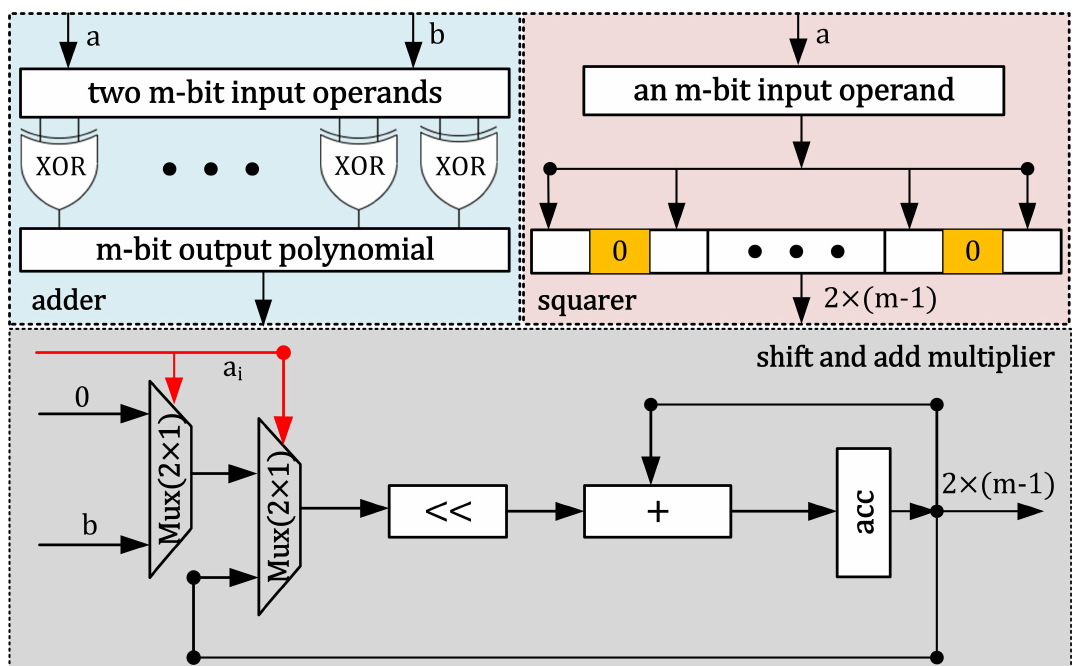
Figure 3. Architectures for polynomial adder, squarer, and Shift and Add